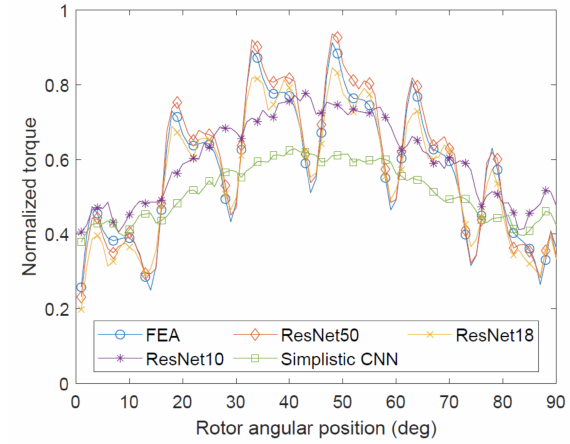
Figure 8. Example of CNN outputs in high-torque